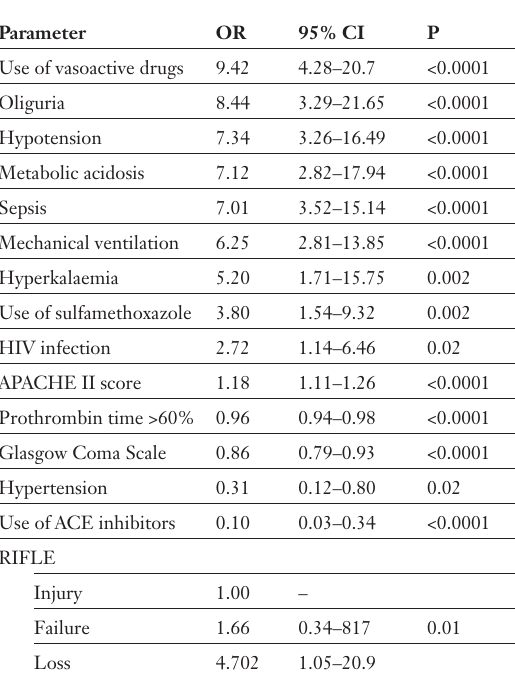
Classification of criti- cally ill patients with infectious disease-as- sociated acute kidney injury according to RIFle criteria in survivors and non- survivors.